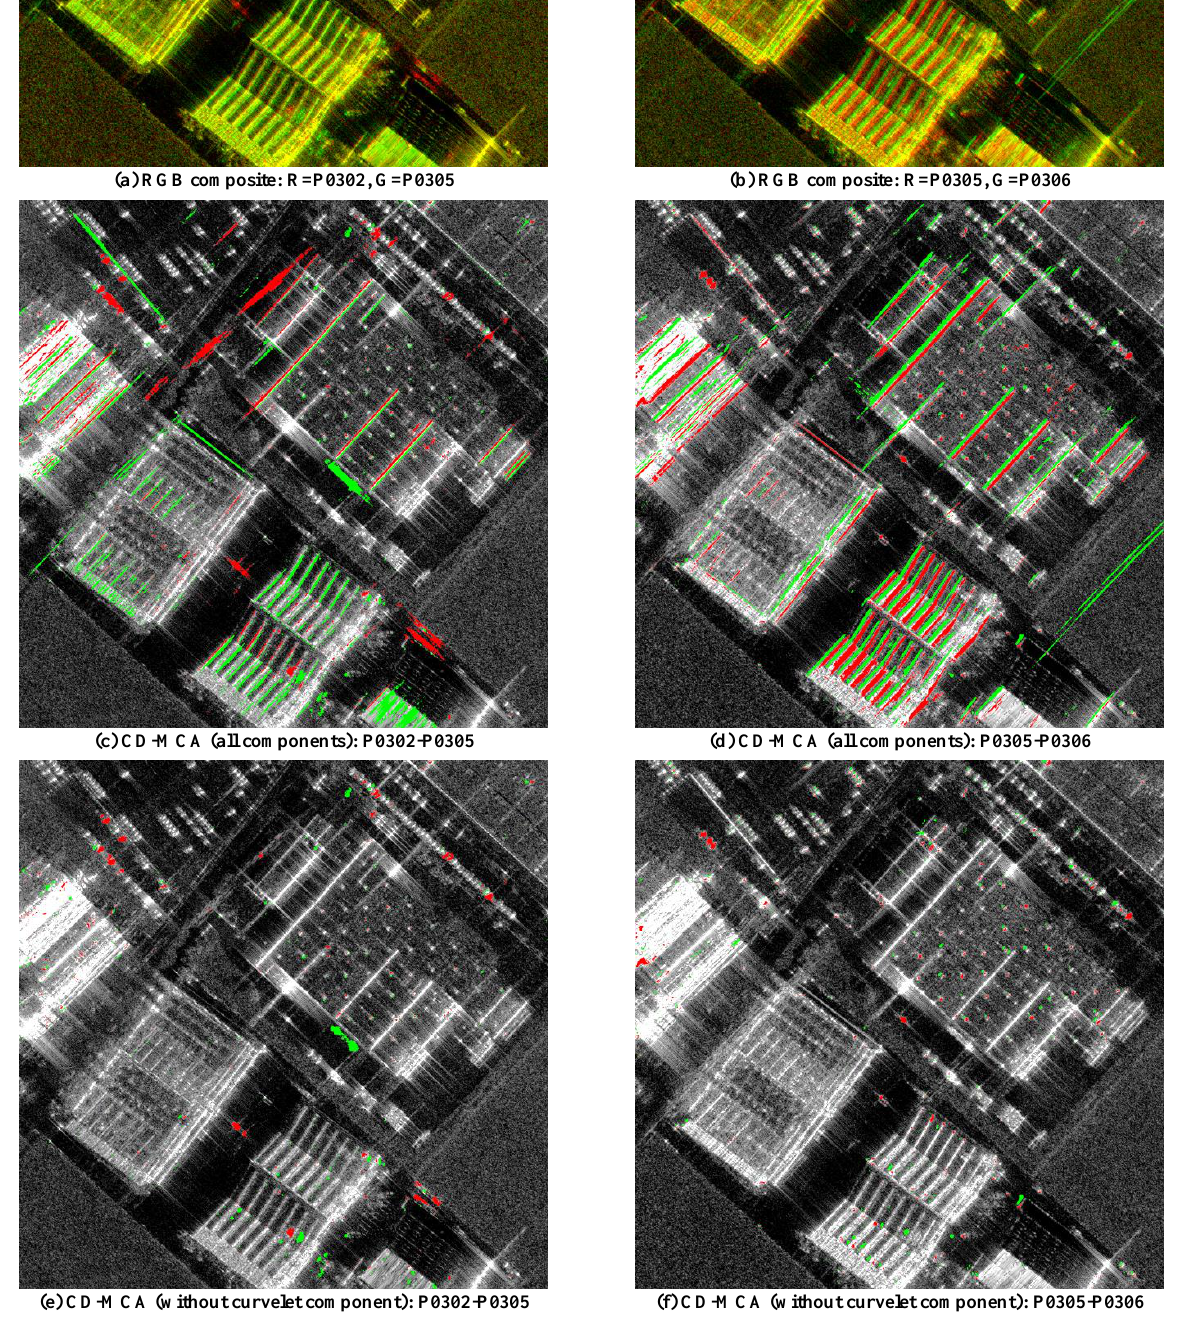
Figure 4. Results of the change detector in the industrial